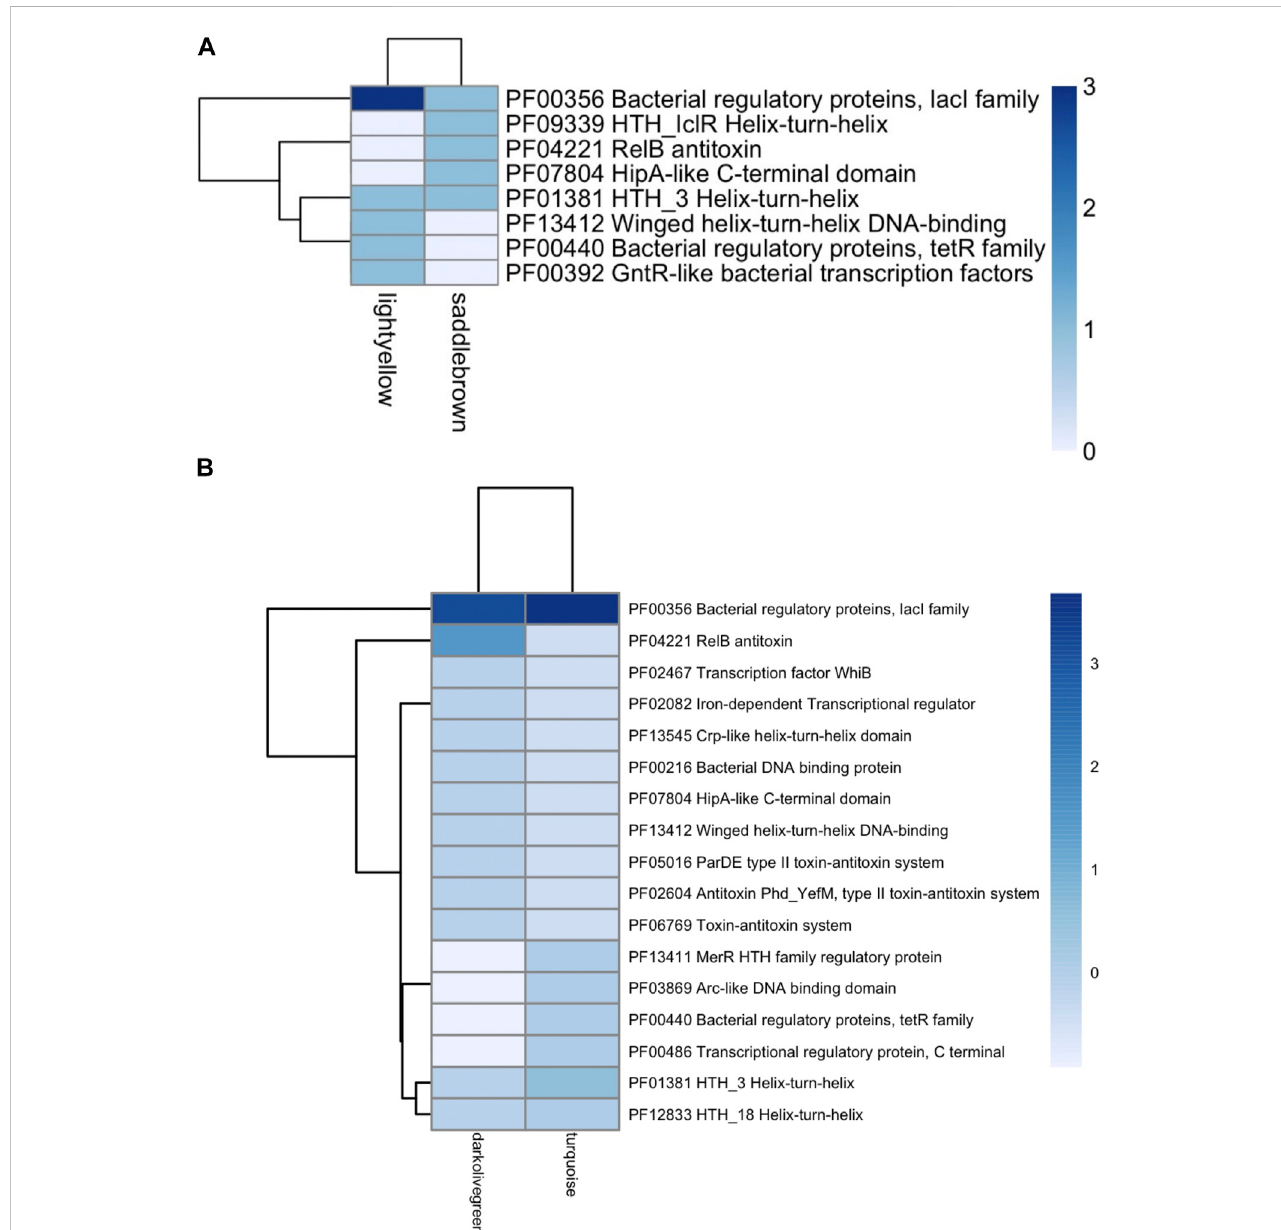
FIGURE 5 Heat map of TFs abundance for Bi fi dobacterium species. (A) B. longum subsp. Infantis ATCC 15697, (B) B. longum subsp. Longum SC596. Each row represents the PFAM, and each column represents the most enriched module for that bacterial